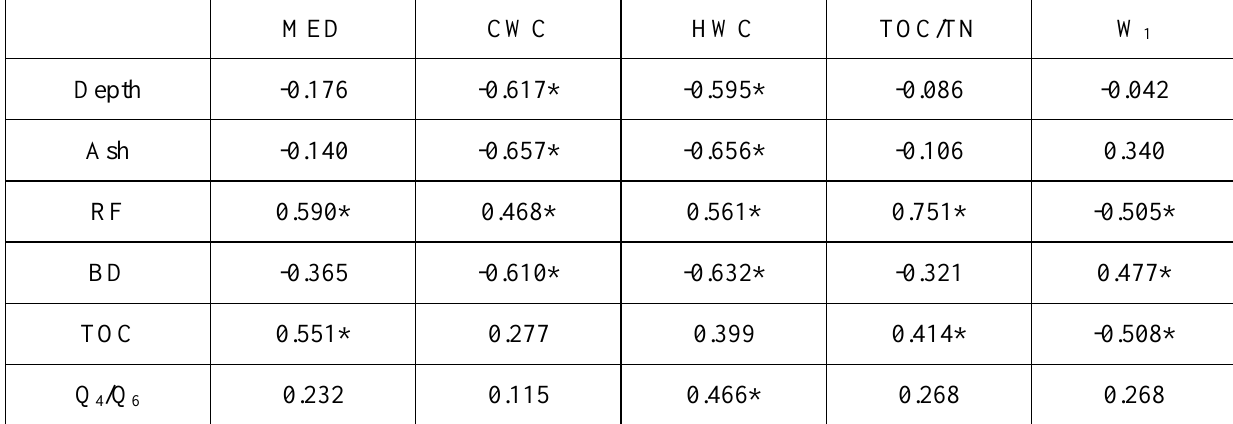
Table 4. Pearson coefficients for soil properties (n = 69). For explanations of symbols see Tables 3 and